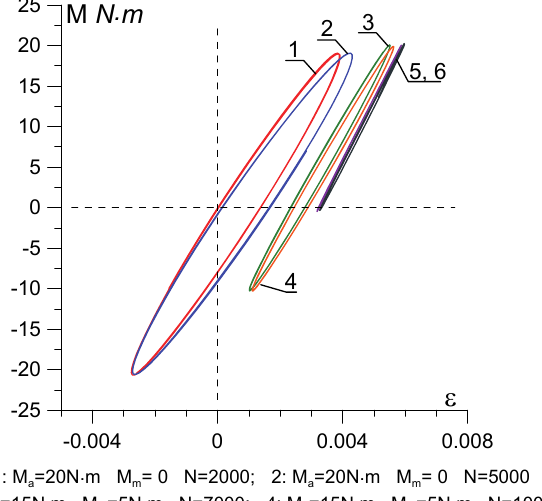
Figure 7: Hysteresis loops at the increasing mean load value.